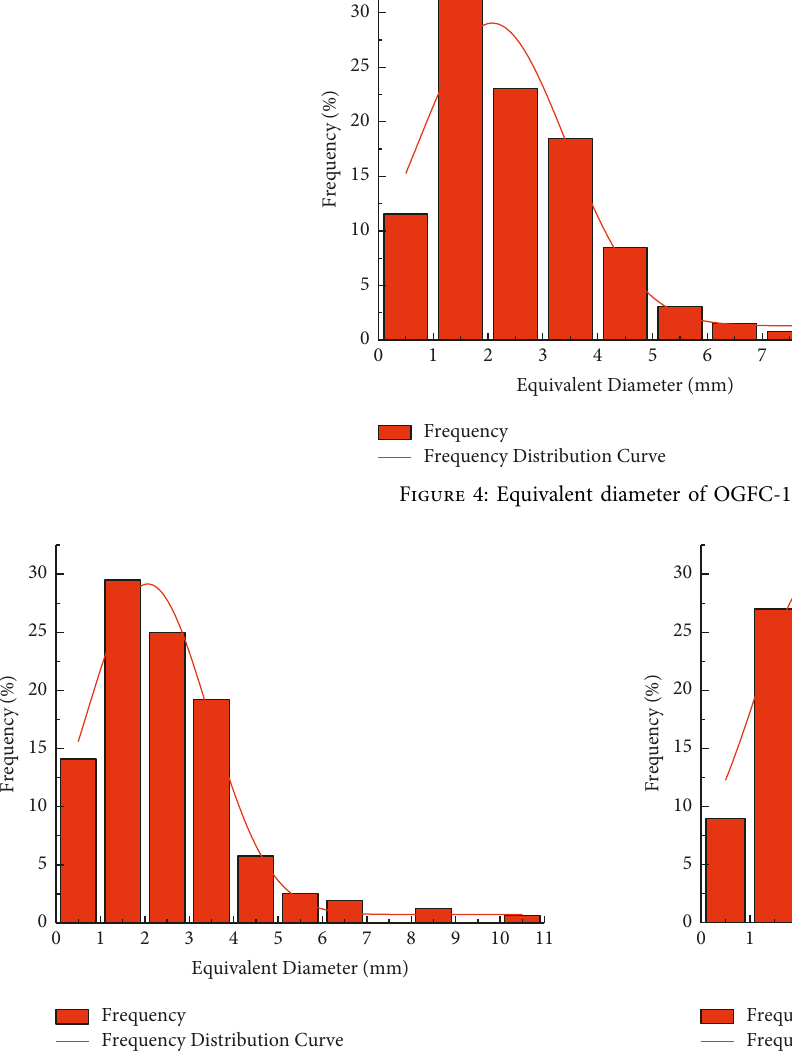
Figure 5: Equivalent diameter of OGFC-2. Figure 6: Equivalent diameter of